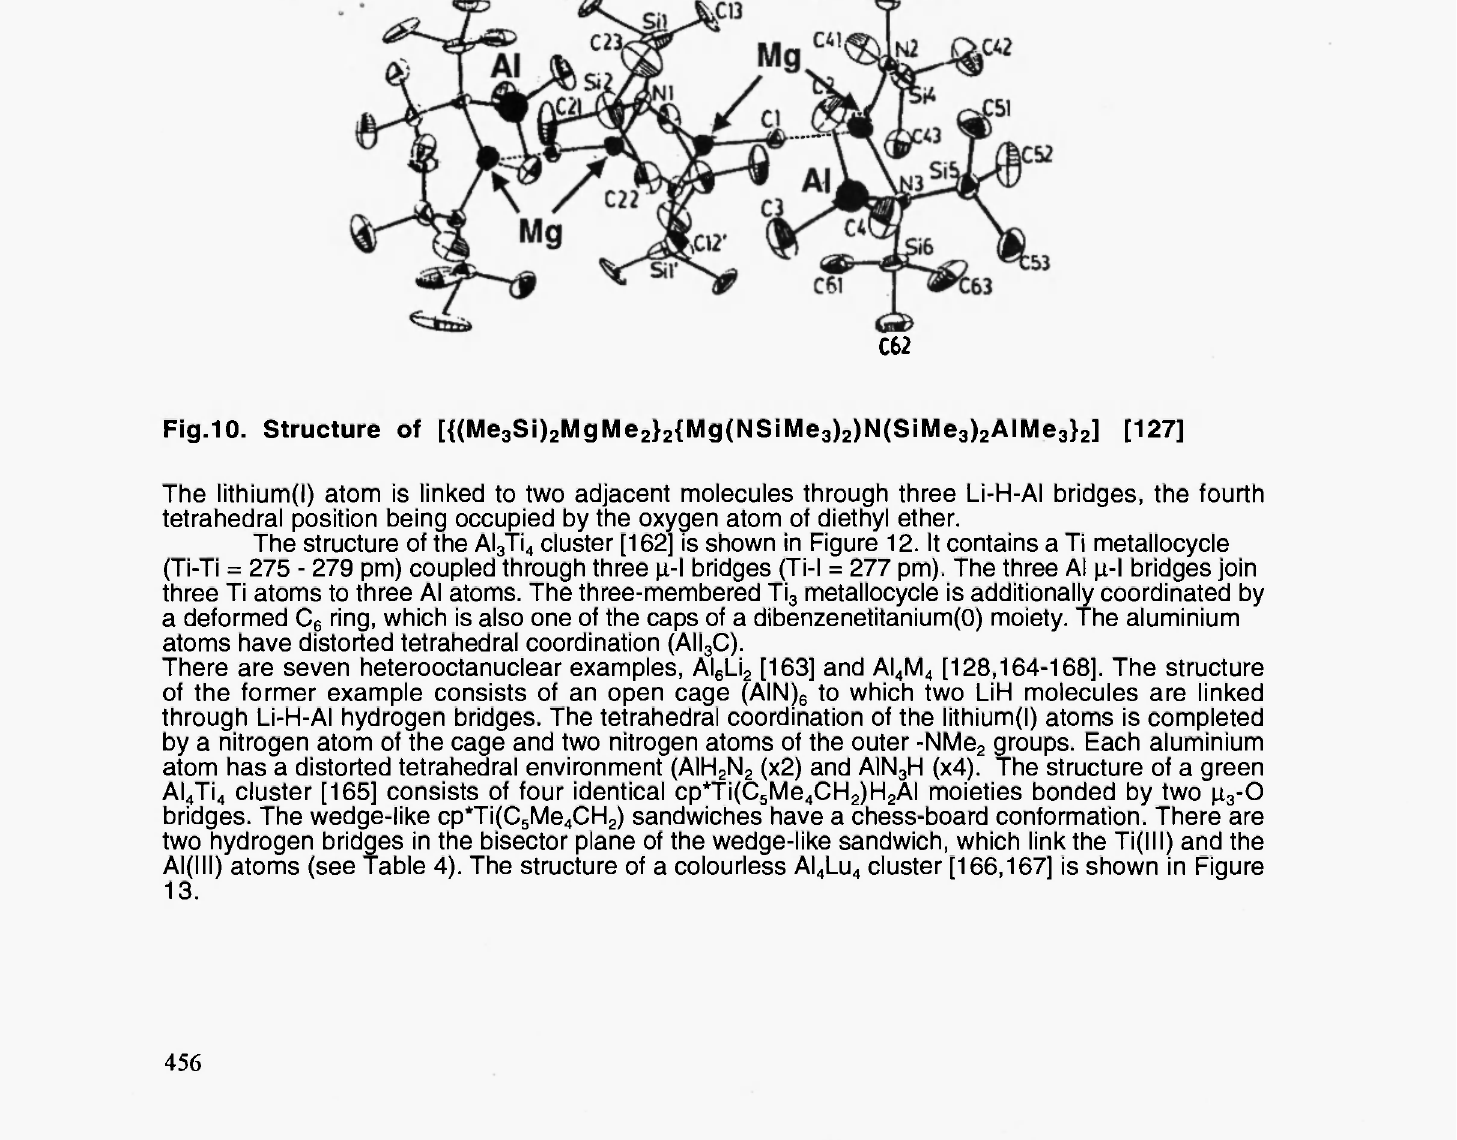
Fig.10. Structure of [{(Me3Si)